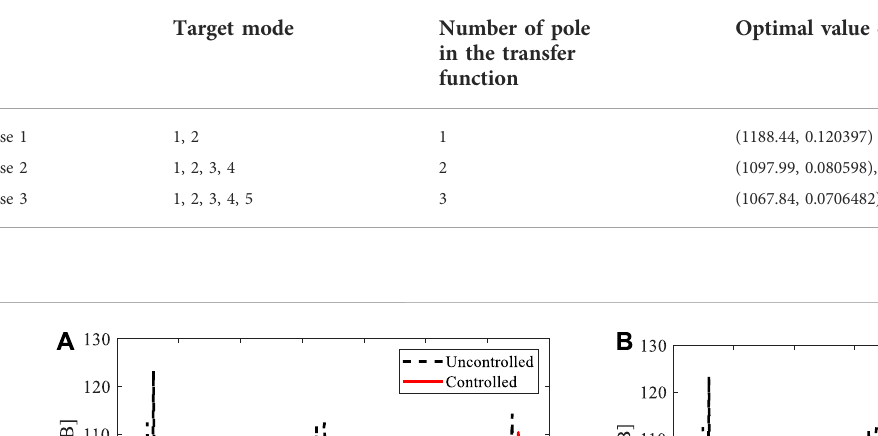
TABLE 2 Optimum parameters of the transfer functions used in different cases.